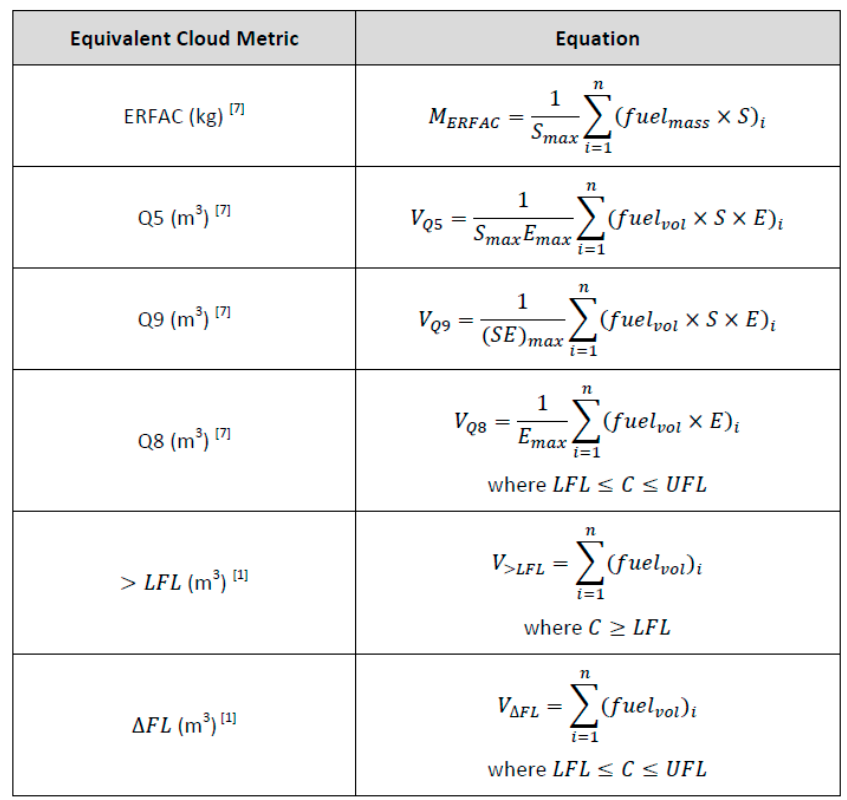
Figure 2. Definition of various equivalent stoichiometric cloud (ESC) volume models (table taken from [15], please note that the references in the table are different from those in the reference section in this paper. They as follows: [12] is (Tam et al., 2008) and [16] is (Hansen et al., 2013). In the equations above, M is the mass in kg, V is volume in m3, S is the laminar burning velocity, and E is the stoichiometric ratio of the fuel/air mixture. Their suffixes refer to specific quantities, e.g., V Q9 is the volume of Q9, S max is the maximum laminar burning velocity of the fuel in air. There are simpler ESC models, such as “>LFL” (volume bounded by LFL) and “ ∆ FL” (volume bounded by the upper flammability limit (UFL) and lower flammability limit (LFL)). They were used by BP following their analysis of large-scale experimental data. Definitions of these ESC models are given in Figure